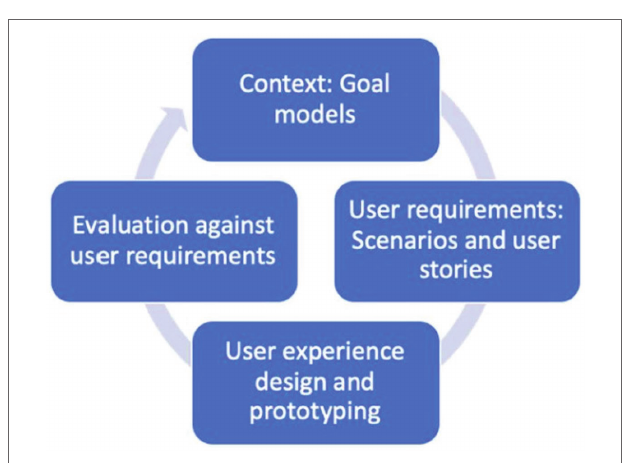
FIGURE 2 | Framework for iterative co-design of the Pharaon